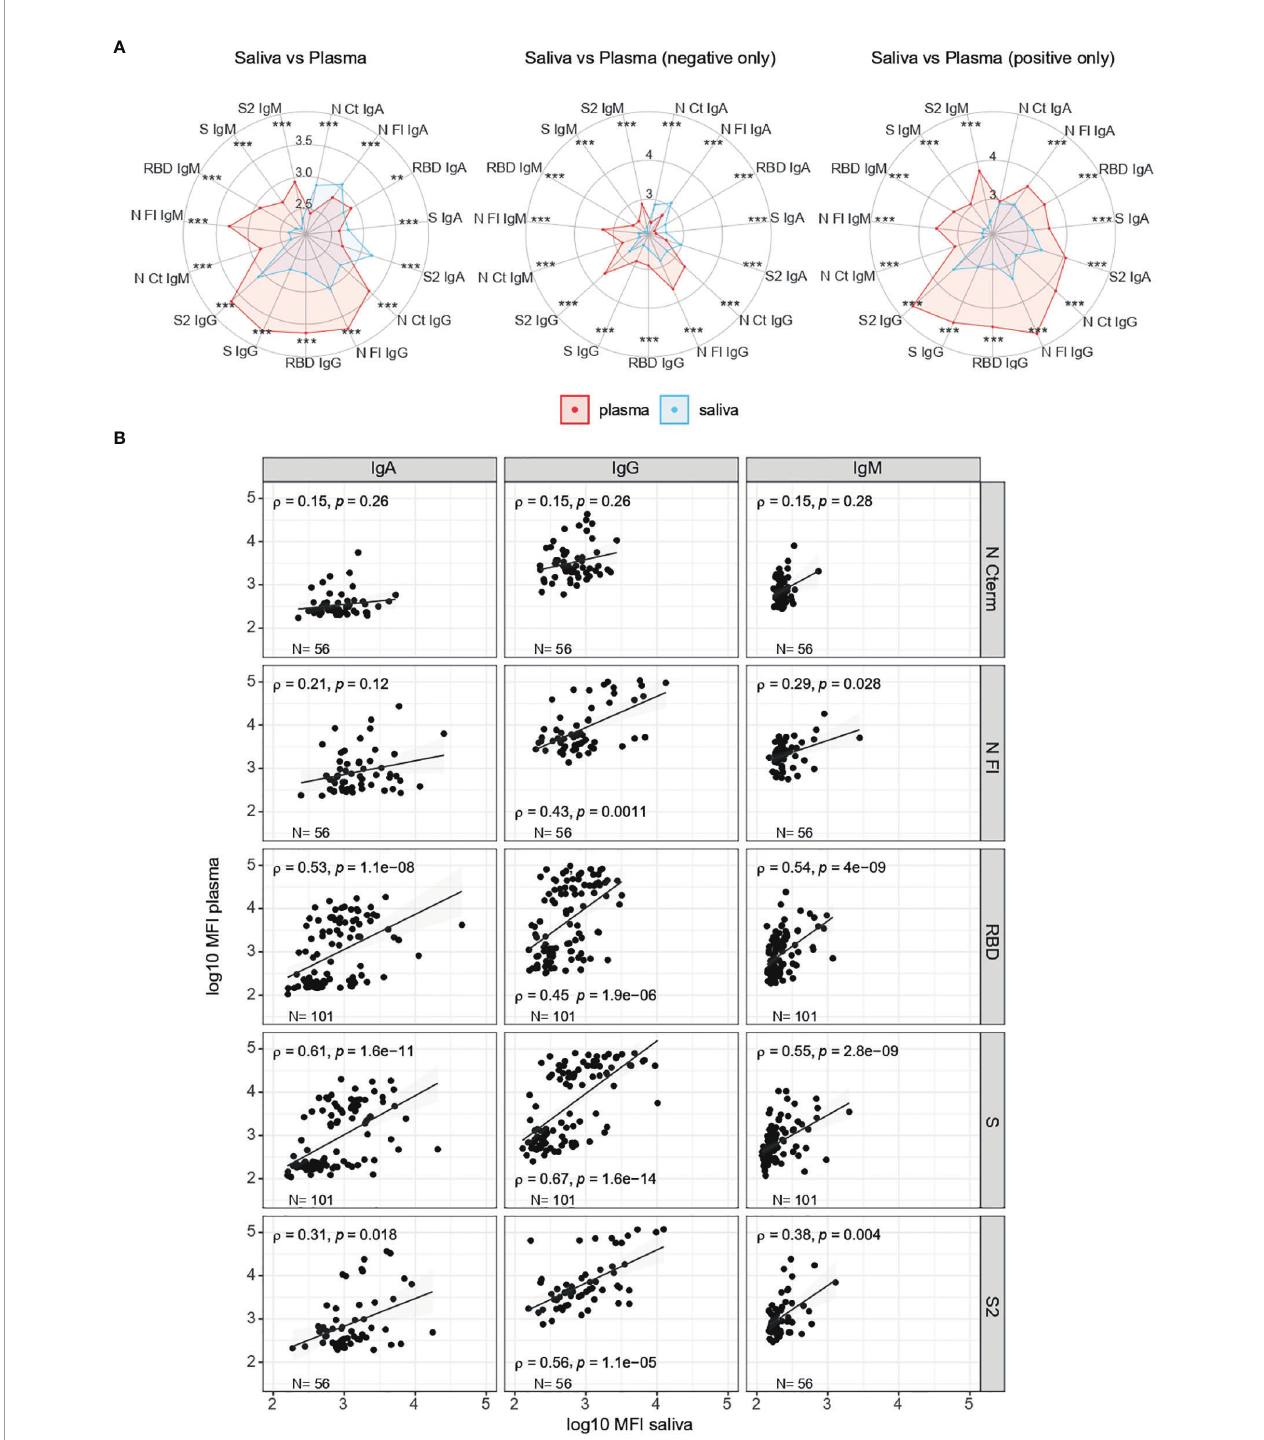
FIGURE 4 | Comparison of antibody levels in serum/plasma and saliva samples. (A) Radar charts comparing the medians of antibody levels (in log 10 MFI) in serum/ plasma (red) and saliva (blue), overall and by RT-PCR status. (B) Correlations of isotype-antigen pair levels between plasma and saliba samples. X axis shows the saliva levels at 1/10 dilution, inactivated; Y axis show serum/plasma levels at 1/500 dilution, not inactivated. Median log 10 MFI antibody levels were compared by Mann-Whitney U test. Statistically signi fi cant raw p-values are highlighted with asteriks. ***p < 0.001, **p <